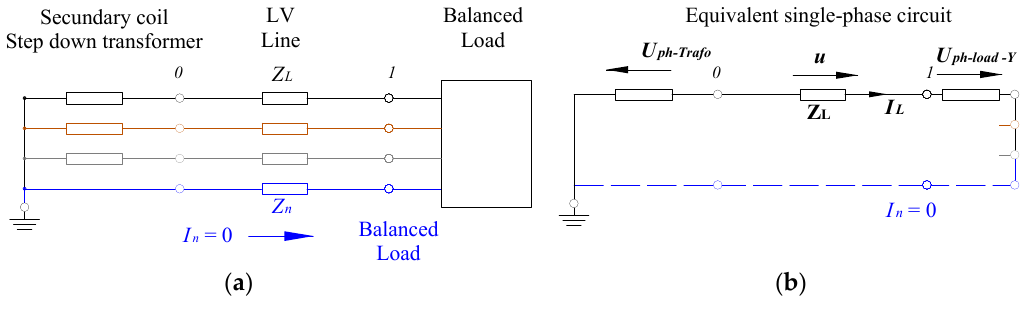
Figure 3. ( a ) Secondary equivalent circuit and the low ‐ voltage (LV) distribution grid; ( b ) single ‐ phase equivalent.